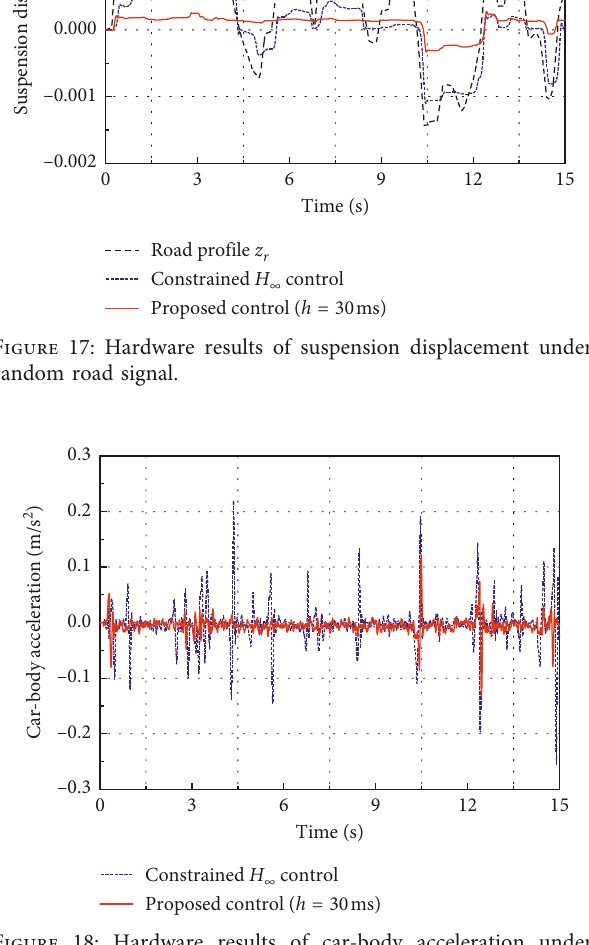
Figure 18: Hardware results of car-body acceleration under random road